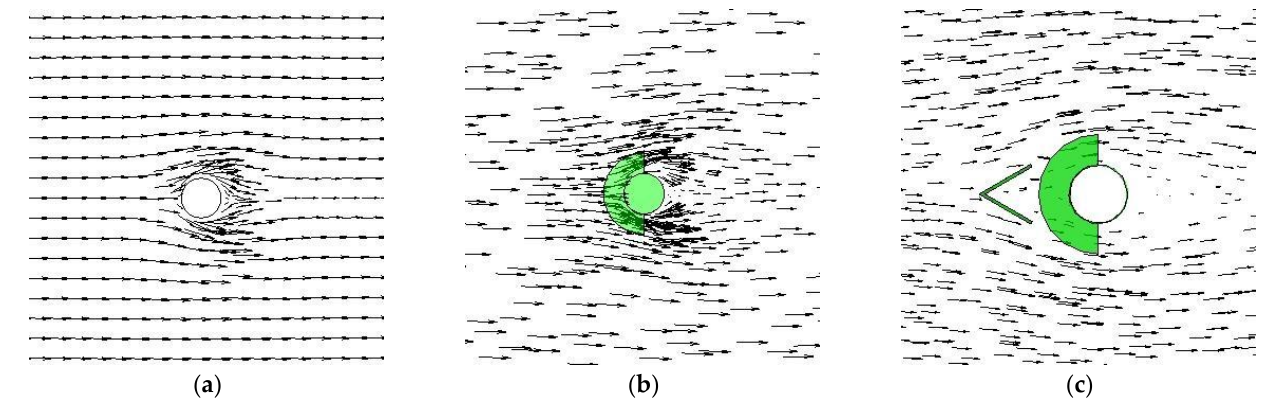
Figure 8. Velocity vectors at Z = 1 cm. ( a ) Single pier; ( b ) Pier with ring-wing plate; ( c ) Pier with combined device.